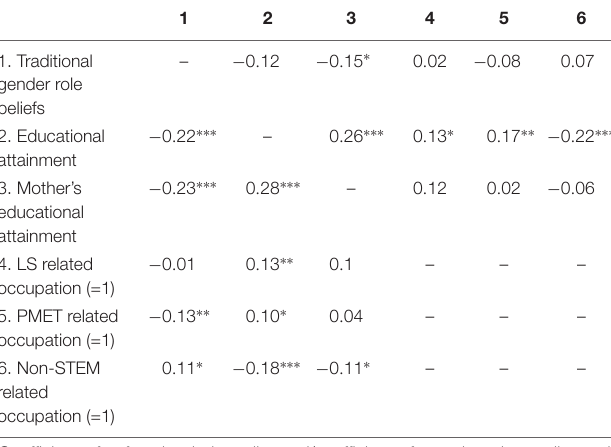
TABLE 2 | Bivariate correlations of relevant variables by